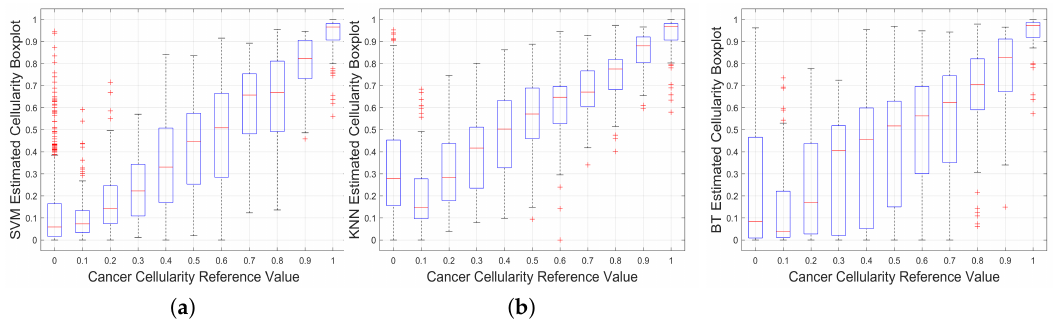
Figure 10. Results of implementation on Training Data. Boxplots for the Cancer Cellularity Reference Value against: ( a ) SVM estimation, ( b ) KNN estimation and ( c ) BT Estimation. It should be noted that large boxplots correspond to large variations of the estimations and as such, SVM shows the lowest variability